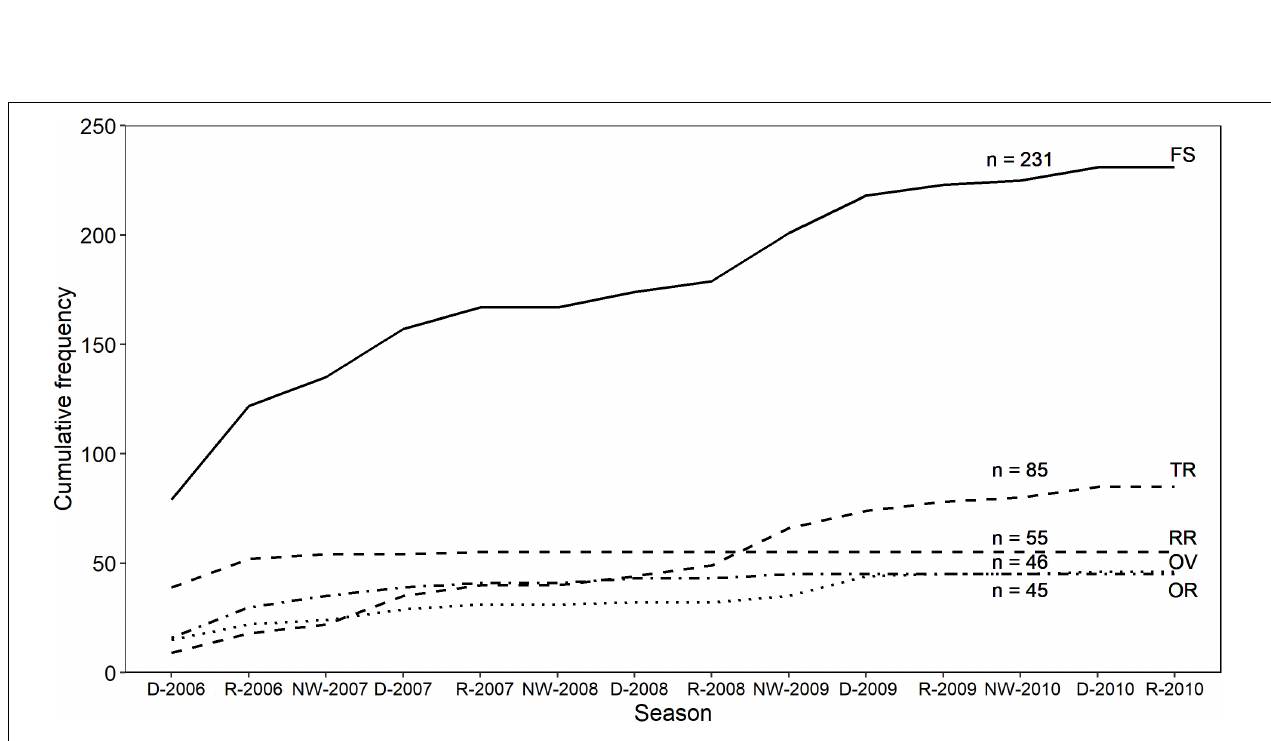
FIGURE 3 | Boxplot of IH 4 values, by season and year, according to the residency pattern. OV = occasional visitors ( n = 46), OR = occasional residents ( n = 45), RR = regular residents ( n = 55).